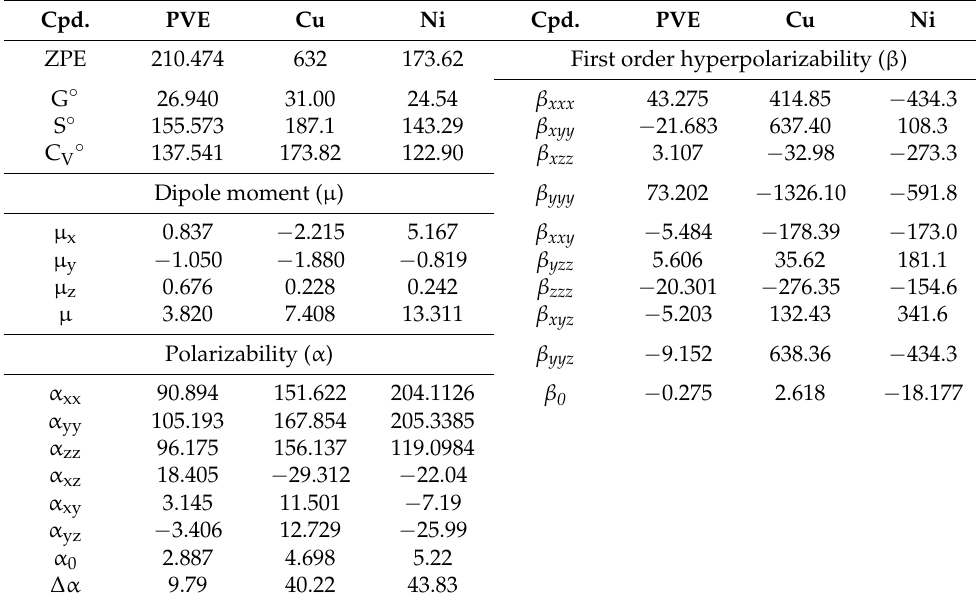
Table 4. Calculated thermodynamic parameters for compounds PVE and MII/PVE at DFT with a B3LYP \ 6-31G* basics sets. Schemes follow the same formatting. Cpd. PVE Cu Ni Cpd.